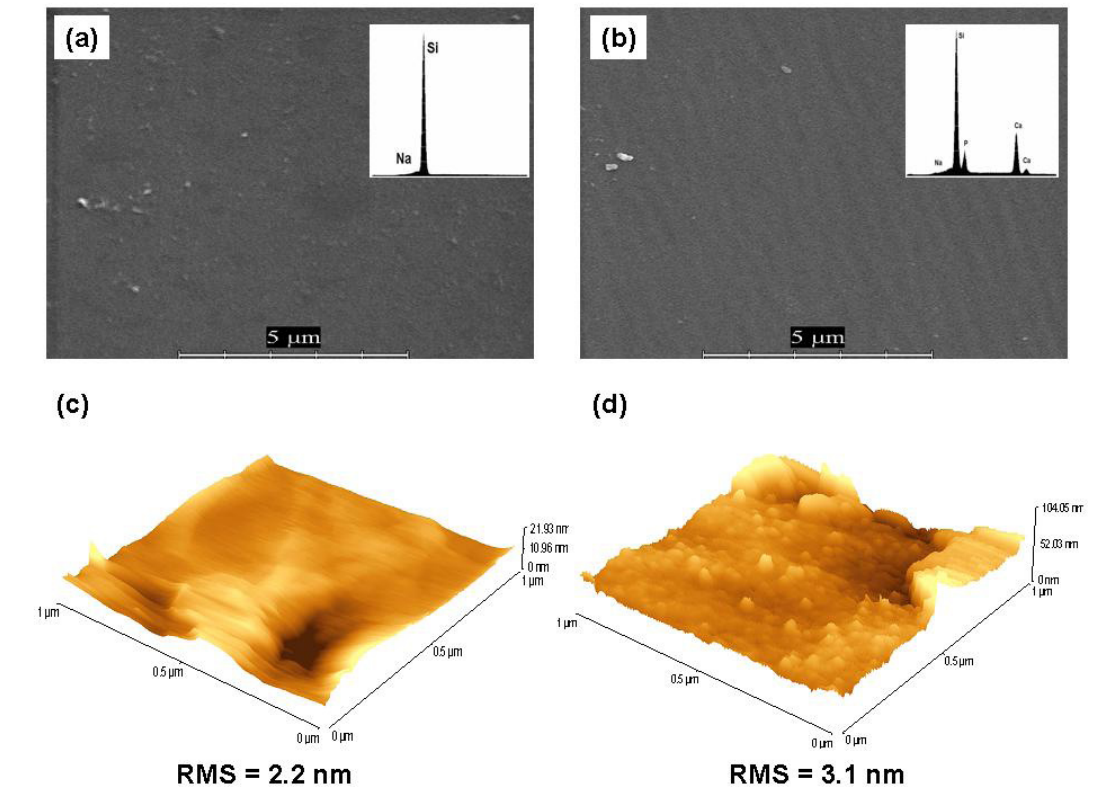
Figure 1. SEM - EPMA surface analysis (a, b) and AFM images (c, d) of glass samples (a, c – G0, b, d – G14) before immersion in